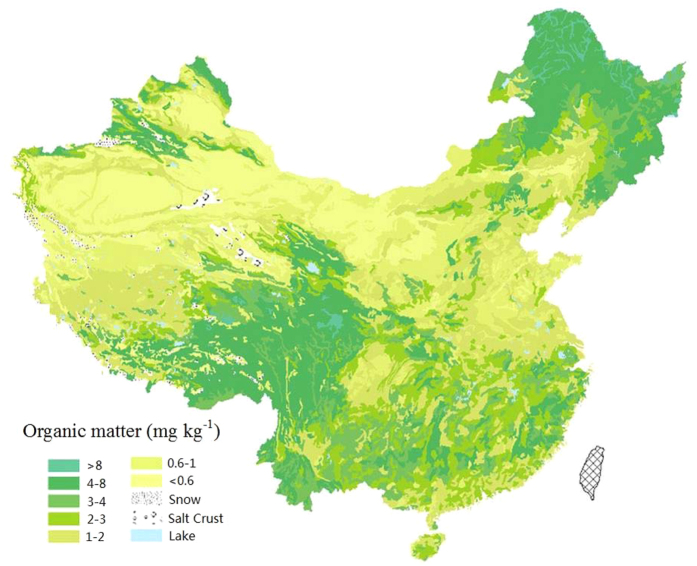
Map of soil organic matter of China (Digital Soil Mapping from Institute of Agricultural Resources and Regional Planning, Chinese Academy of Agricultural Sciences,http://www.caas.ac.cn/datashare/spatialdata/om2ndse.jpg).